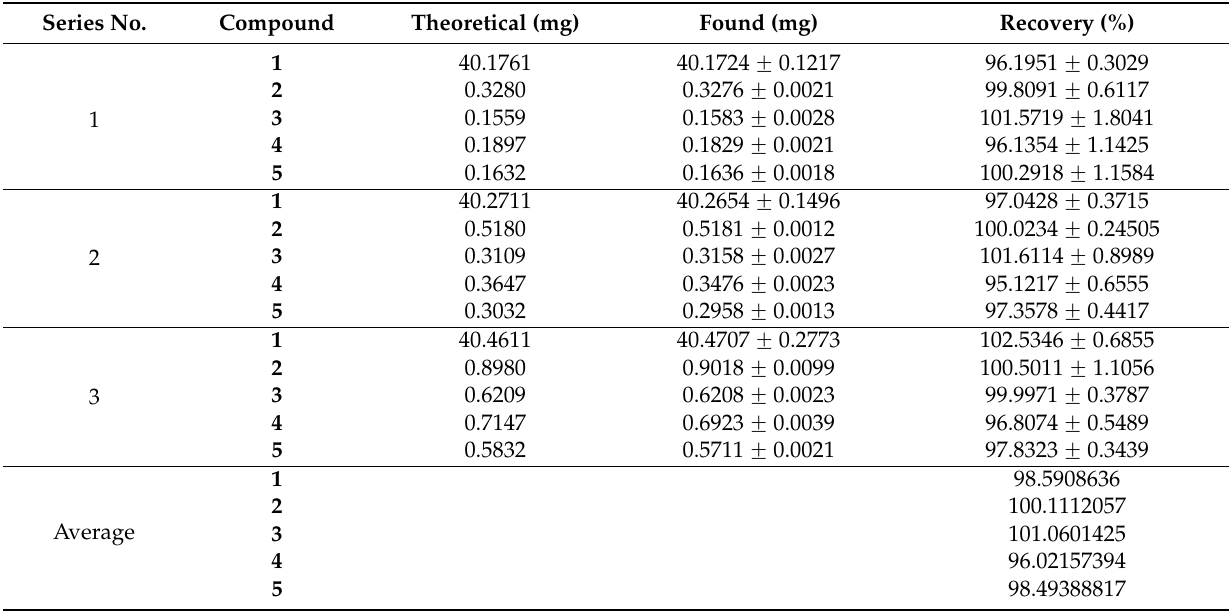
Table 8. Recovery studies of rutin ( 1 ), quercetin ( 2 ), genistein ( 3 ), kaempferol ( 4 ), and isorhamnetin ( 5 ). Series